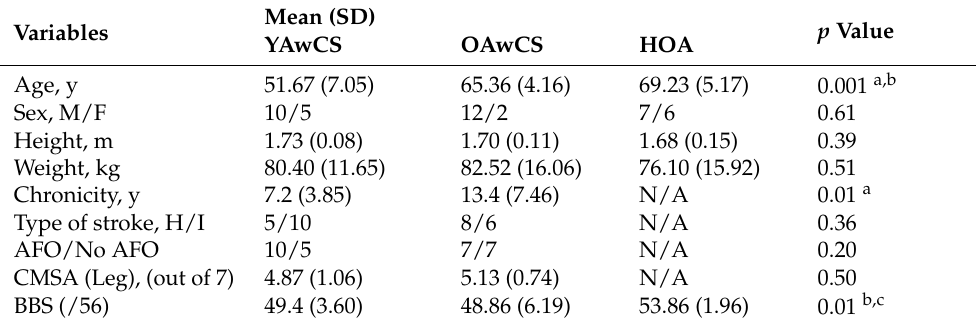
Table 1. Demographic characteristics and clinical outcomes of participants with their respective means and standard